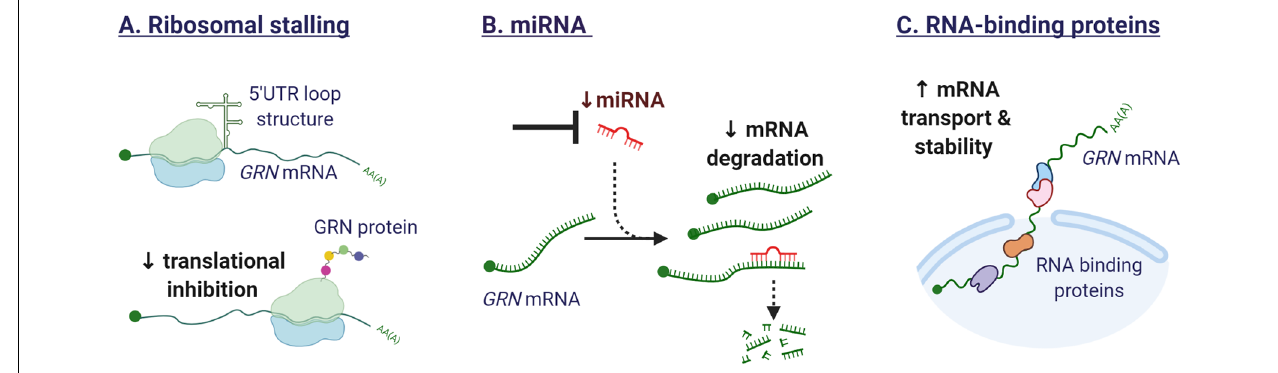
FIGURE 5 | Mechanisms affecting GRN translation. (A) The secondary structure of the 5 (cid:48) untranslated regions (UTR) in the GRN transcript can affect ribosomal function. The formation of a loop structure can hinder efficient translation. (B) Several miRNA have been identified that target GRN mRNA and repress GRN protein synthesis. Synthetic oligonucleotides could sequester endogenous miRNAs or mask miRNA target sequences in the GRN mRNA , leading to enhanced gene expression. (C) RNA-binding proteins are potential therapeutic targets as they affect the splicing, mRNA transport, stability, and translation of GRN mRNA